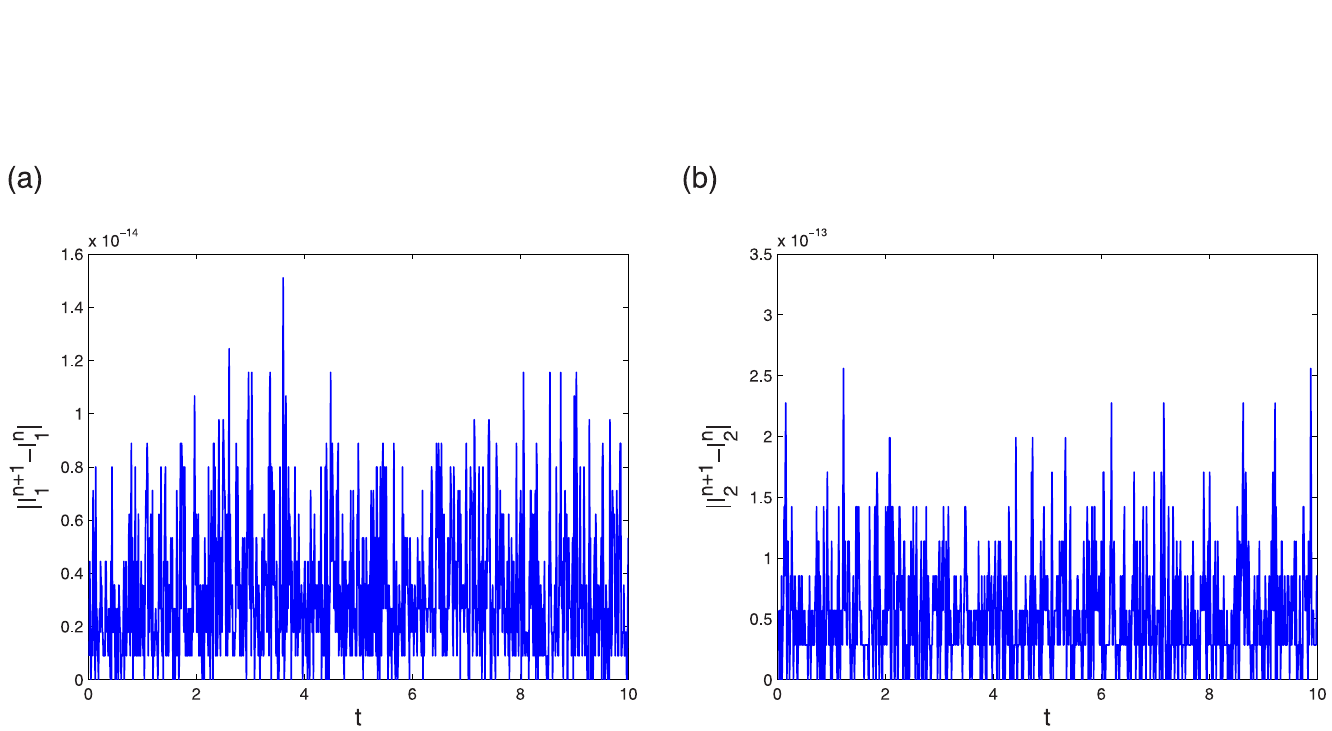
Fig 5. Discrete energy I n